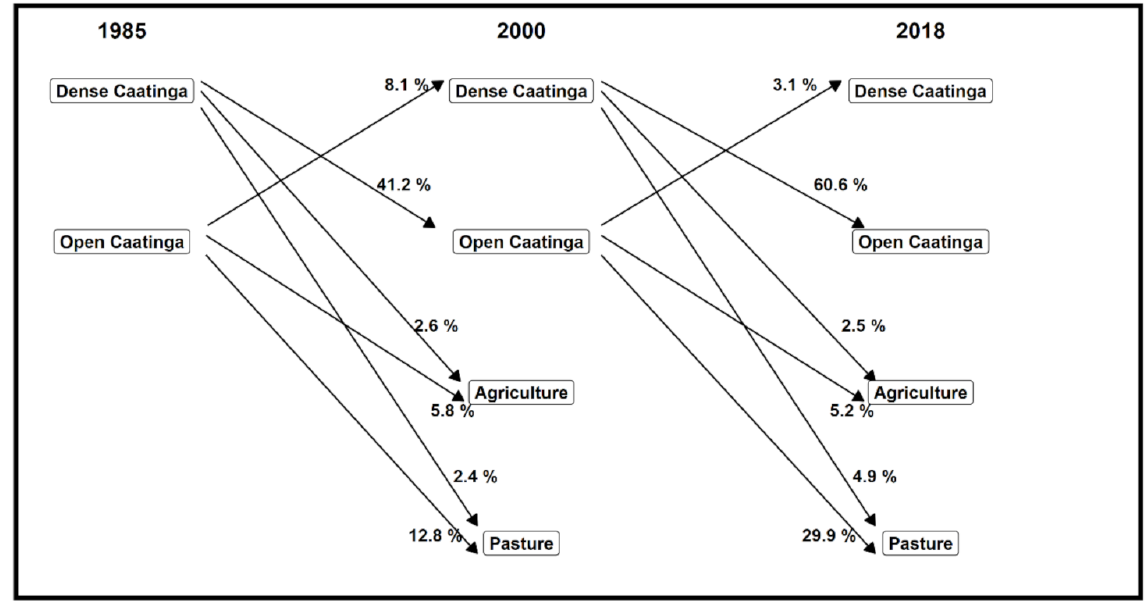
Figure 4. Major change trajectories and their contributions to net change in percentage of the study